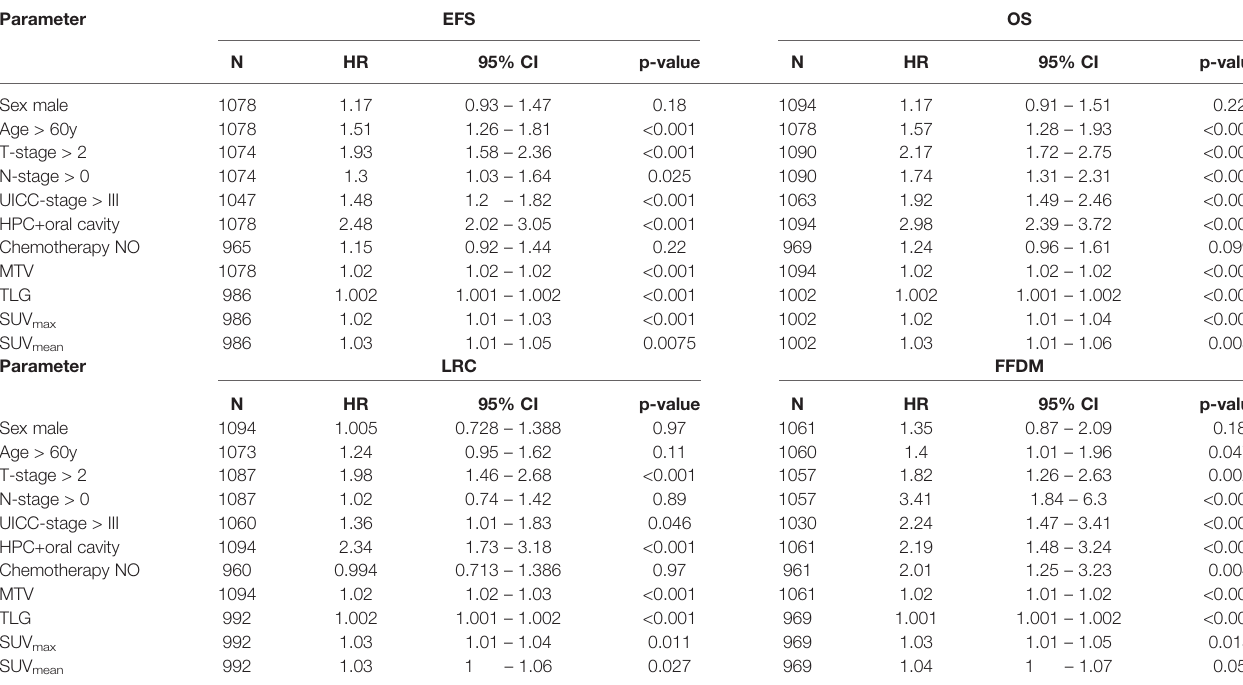
PET parameters were included as metric parameters. Column ‘ N ’ shows the number of included patients in the respective